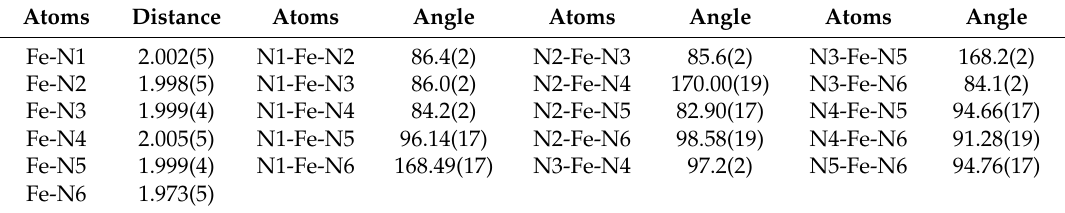
Table 2. Bond distances (Å) and angles ( ◦ ) for compound [Fe(L6)](ClO 4 ) 2 ( 1 ). Atoms Distance Atoms Angle Atoms Angle Atoms Angle Fe-N1